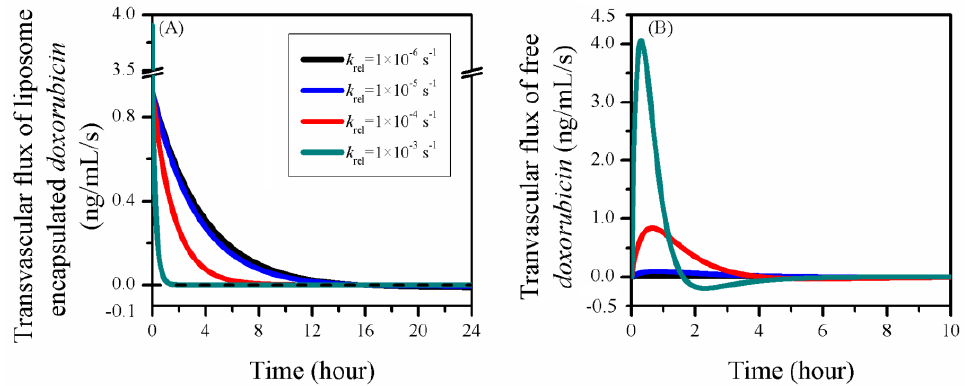
Figure 9. The time courses of drug transvascular flux in the treatments using liposomes with different release rates. ( A ) Liposome-encapsulated doxorubicin and ( B ) free doxorubicin.